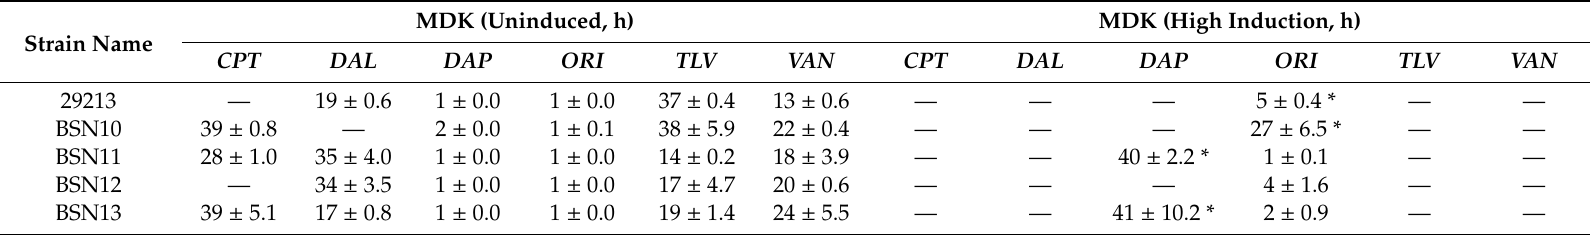
Table 2. Time to bactericidal activity under high induction conditions. Under high mupirocin exposure, MDK is prolonged or not achieved for most isolates and antibiotics. Dashed line (—), MDK not achieved over 48 h; *, p <